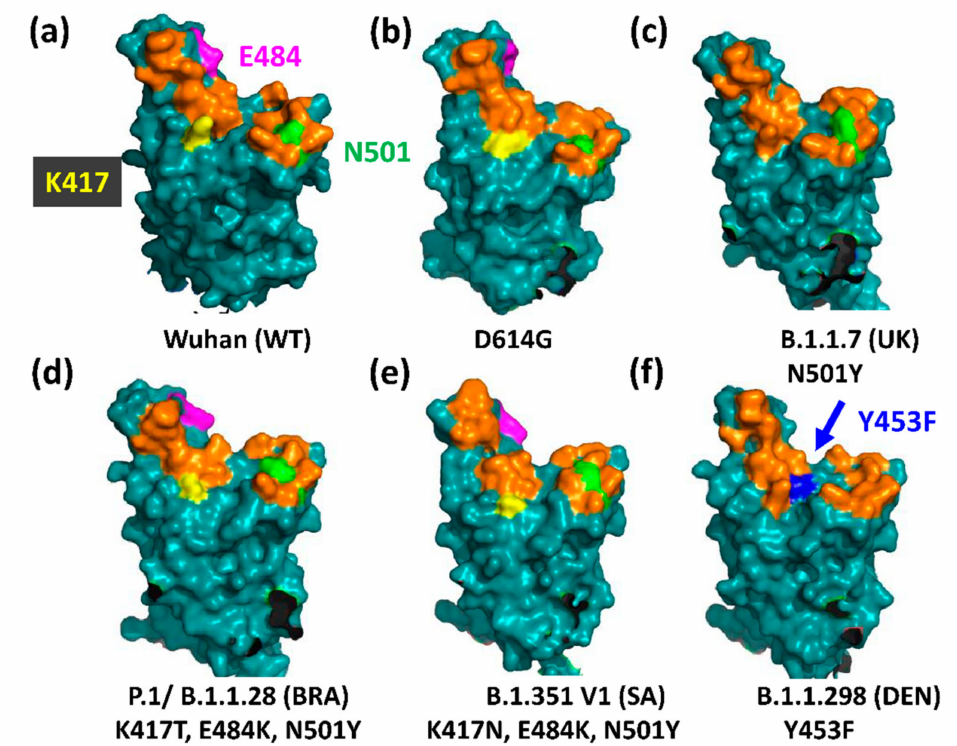
Figure 5. Surface structure of the hAce2 binding site of Spike and its variants. ( a ) The Wuhan strain. The 17 amino acids making direct contact with hAce2 are highlighted in orange, K417 in yellow, N501 in green and E484 in magenta [9]; ( b ) D614G (PDB: 7BNN); ( c ) B.1.1.7 (UK) (PDB: 7LWT); ( d ) P.1/B.1.1.28 (Brazil) (PDB: 7LWW); ( e ) B.1351 V1 (South Africa) (PDB: 7LYQ); ( f ) B.1.1.298 (Denmark) (PDB: 7LWO); only the Wuhan structure was modelled with Phyre2 (Protein Homology/analogy Recognition Engine V 2.0) and visualised with EzMol2.1 [63,64]; the other structures are visualisations of the published structural data sets with the complete coverage of the RBD (i.e., no unstructured regions). Visualisation with PyMOL (Molecular Graphics System, Version 2.0 Schrödinger, LLC). Wuhan spike protein sequence: UniProt